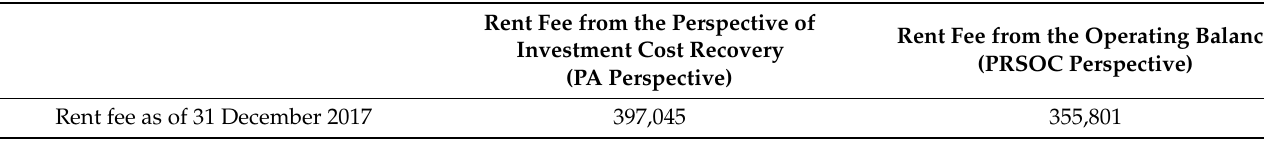
Table 11. Proper rent fee from the perspective between PA and PRSOC (units: U.S.